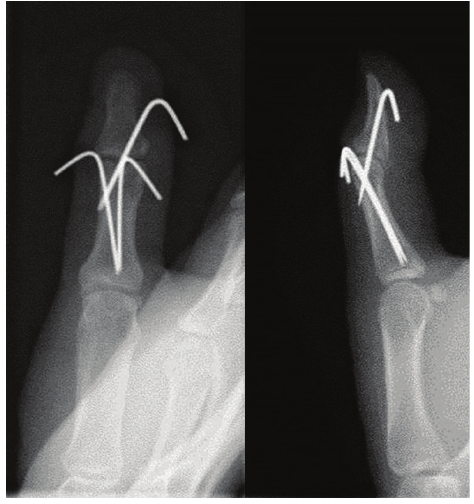
Figure 1: The plain radiograph shows a bony mallet thumb.